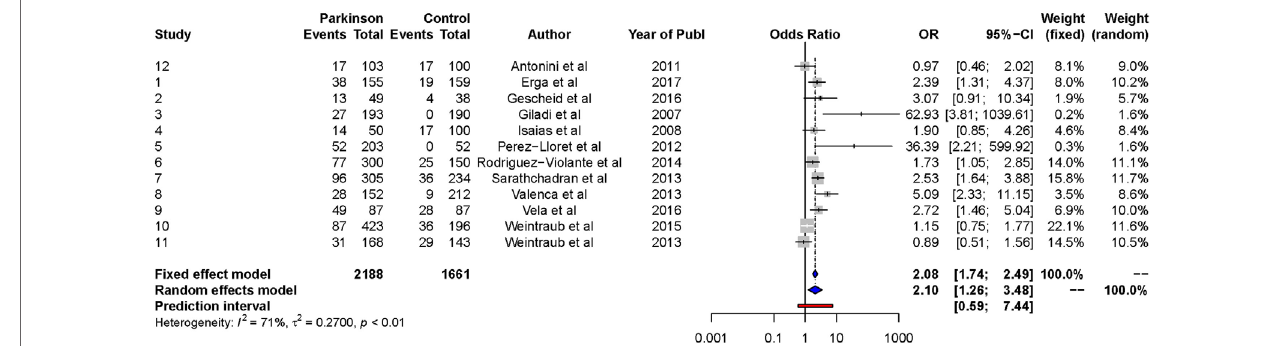
FigURe 2 | Forest plot of any